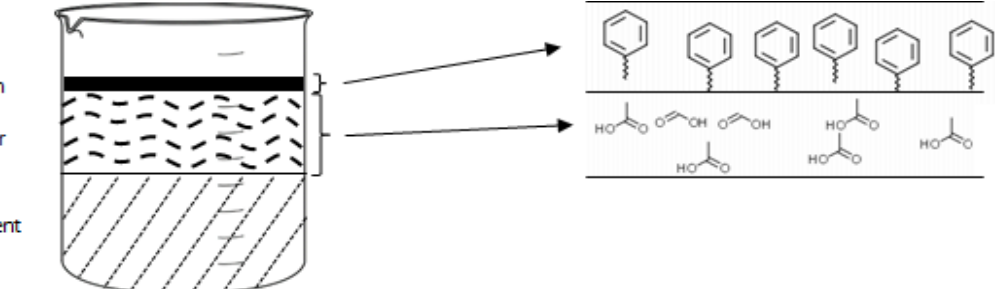
Figure 5. Possible separation layers of treated MFT samples into froth, water, and sediment. En- hancement is of possible assumption of froth layer showing nonpolar organic rings and water layer showing dissolved acetic and formic acids.